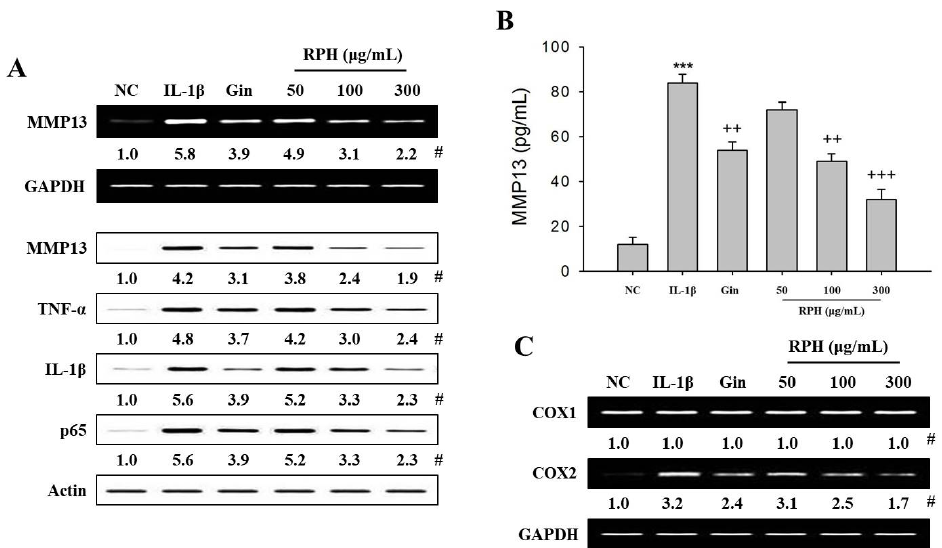
Figure 1. Effects of natural product mixture (Ryupunghwan (RPH)) on the expression or amount of osteoarthritis (OA)-related molecules or cyclooxygenase (COX) in IL-1 β -stimulated chondrosarcoma SW1353 cells (SW1353 cells). SW1353 cells (1 × 10 6 cells) were stimulated with 20 µ g/mL IL-1 β for 24 h. Natural product mixture (RPH, 50, 100, 300 µ g/mL) or ginsenoside (Gin, 300 mg/mL) was pretreated for 1 h before IL-1 β . The expression of MMP13, COX-1, COX-2, TNF- α or I κ B α was determined in protein or mRNA extracts isolated from the cell lysates using Reverse Transcription-Polymerase Chain Reaction (RT-PCR) or Western blot, respectively. Amount of MMP13 was determined in the cell supernatant isolated from IL-1 β -stimulated cells using enzyme-linked immunosorbent assay (ELISA) kit. ( A ) Expression of MMP13 and OA-related molecules (TNF- α , IL-1 β , or I κ B α ). ( B ) Amount of MMP13. ( C ) Expression of COX1/2. #, Numbers below band images show the mean values ( n = 4) obtained from the ratio of band density of each group versus those of the control and loading control GAPDH or actin. Results for ELISA assay represent the mean ± SEM ( n = 4) obtained from four independent experiments performed in triplicates. NC, negative control; IL-1 β (interleukin 1 beta), IL-1 β -stimulated SW1353 cells; Gin, ginsenoside. ***, p < 0.001 versus the NC. ++ , p < 0.01; +++ , p < 0.001 versus the IL-1 β